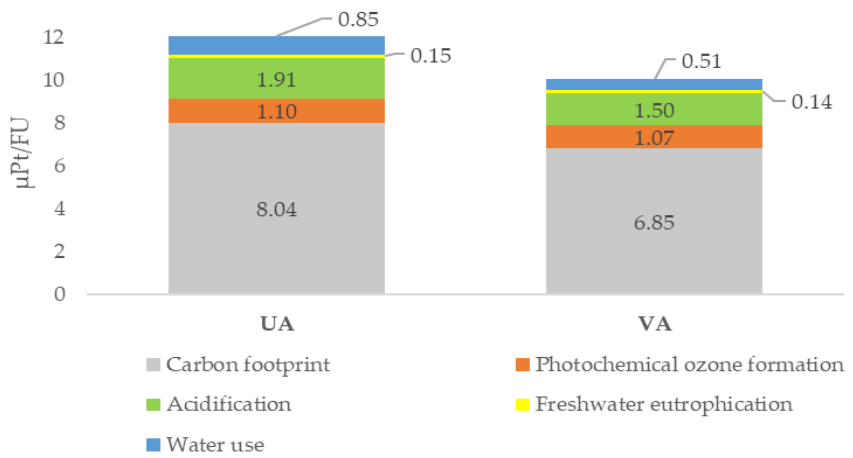
Figure 3. EF3.0 single-score environmental impact of the manufacturing of cultivation inputs substage in the production of nectarines using conventional UA and precision agriculture VA practices.